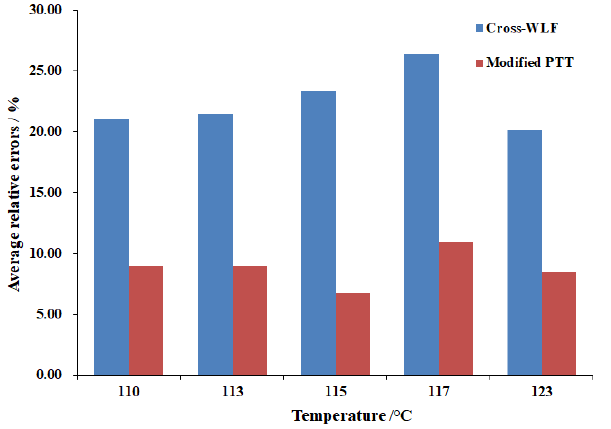
Figure 8: Average relative errors between simulations and experi- ments for rotational rheological test